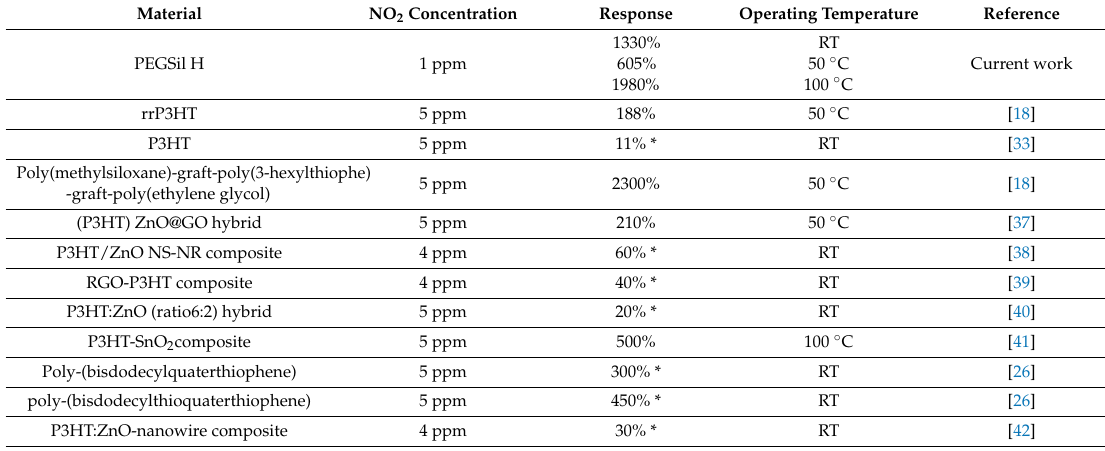
Table 4. Comparison of the responses of P3HT-based receptor structures to NO 2 .